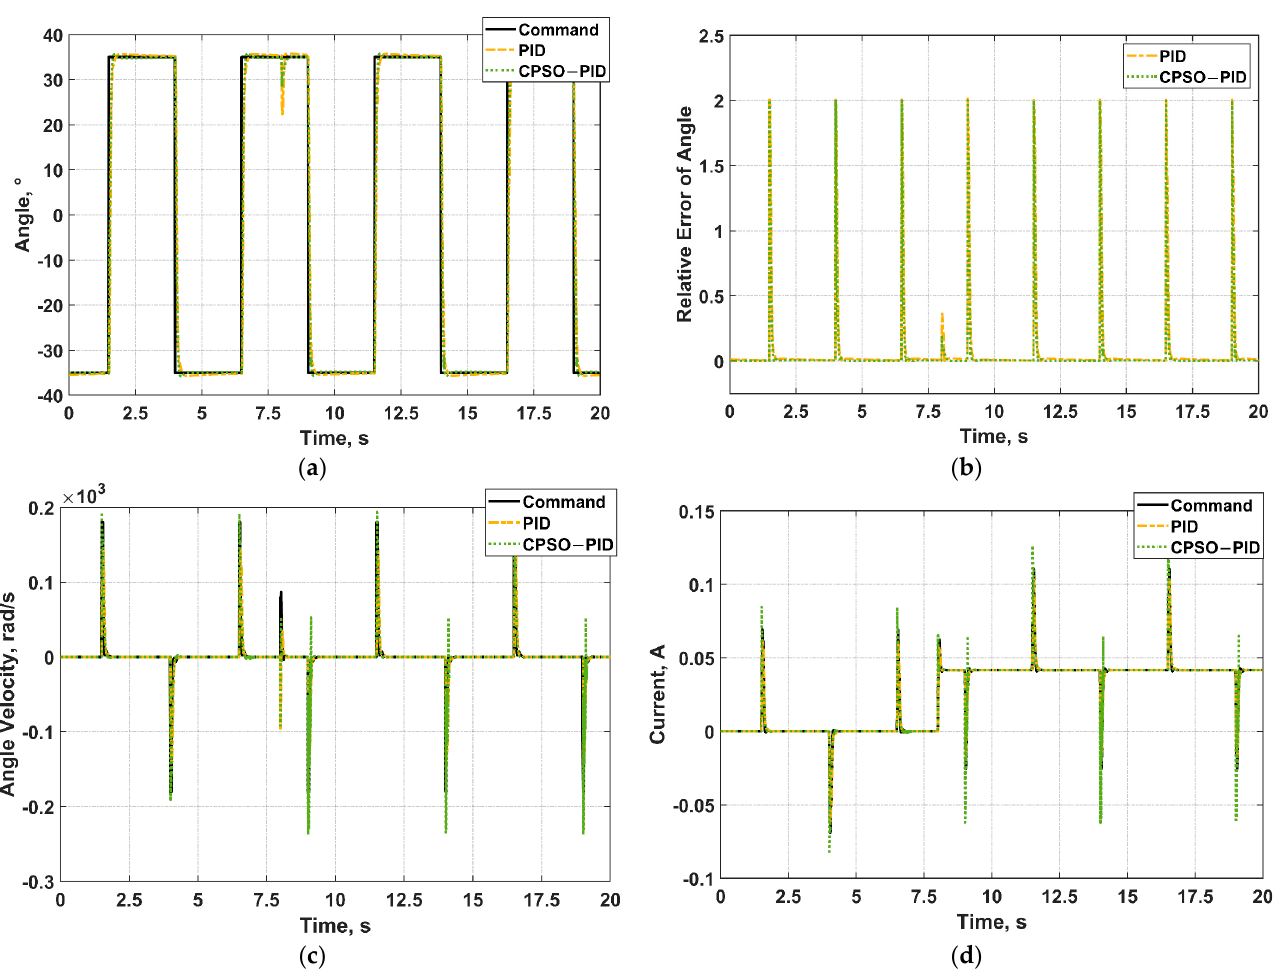
Figure 14. The simulation result when the angle command input signal is a square wave with frequency of 0.2 Hz adding a step load at t = 8 s. ( a ) Angle control; ( b ) Relative error of angle; ( c ) Angle velocity control; ( d ) Current control.